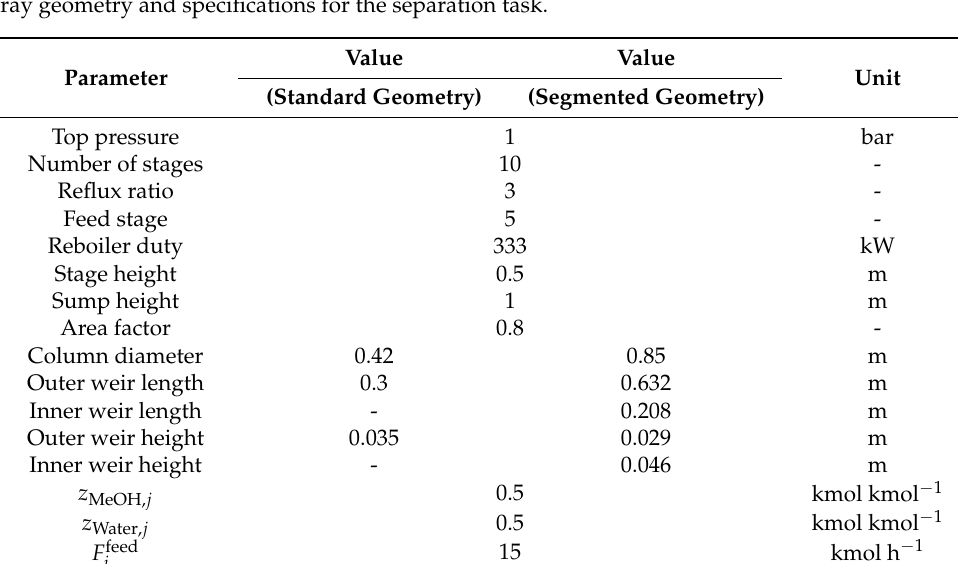
Figure 4. Visualization of the assumptions in the case study. Table 1. Design and operating parameters for the segmented column and the column with standard tray geometry and specifications for the separation